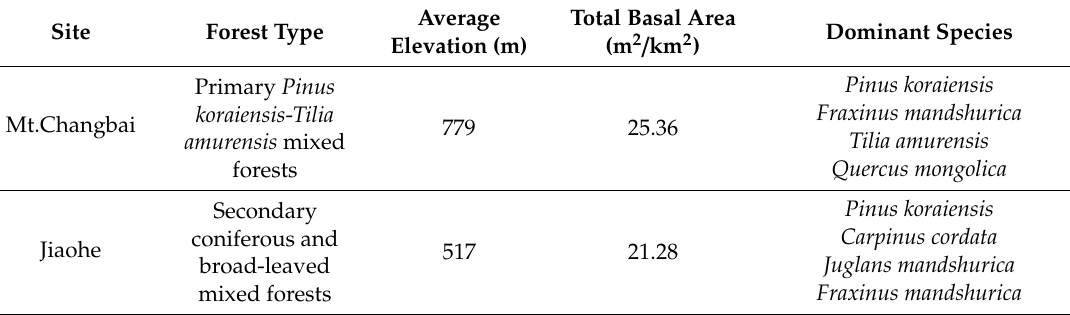
Table 1. A summary of permanent forest plots in Mt. Changbai and